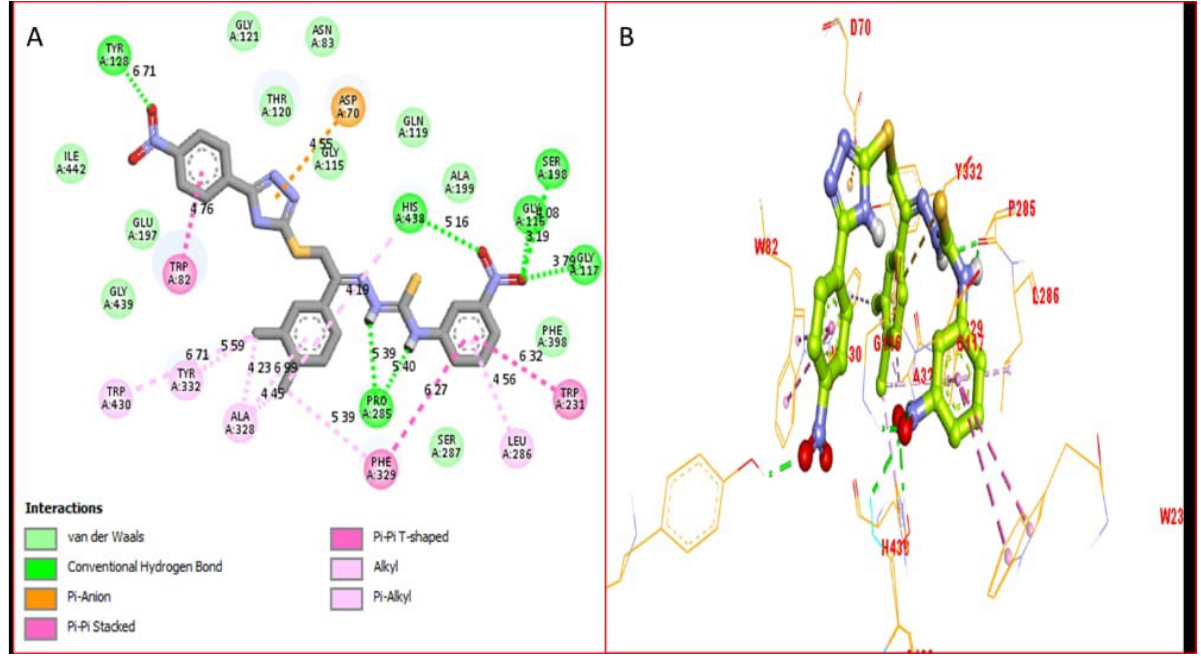
Figure 9. Protein–ligand interaction (PLI) profile of analogue 6q against acetylcholinesterase (AChE): ( A ) 2D; ( B ) 3D.